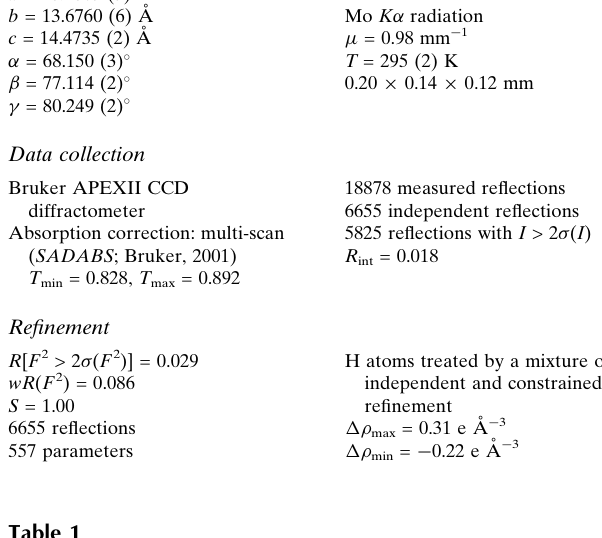
Hydrogen-bond geometry (A˚ , (cid:2)